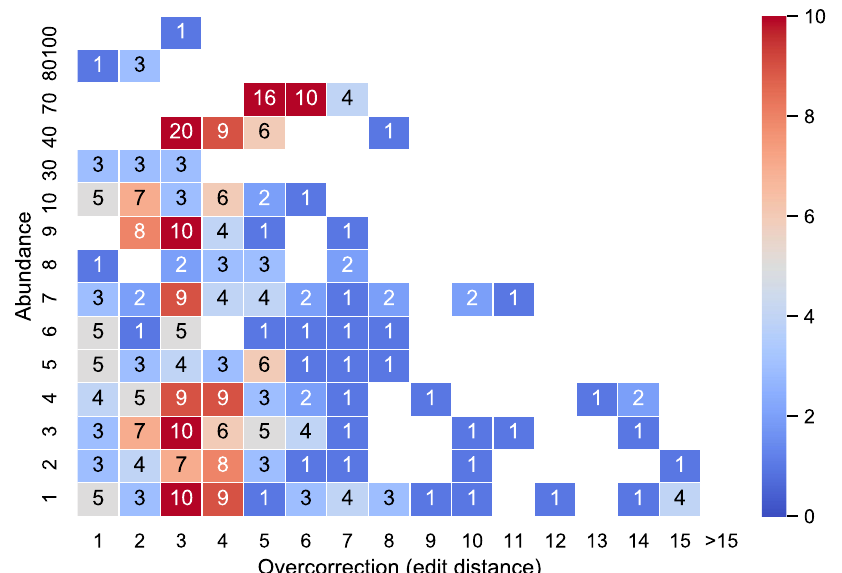
Fig. 4 The effect of overcorrection in SIM-ca. We bin each overcorrected read according to the abundance of its true transcript ( y -axis) and its overcorrection distance ( x -axis). Each cell shows the number of reads in the